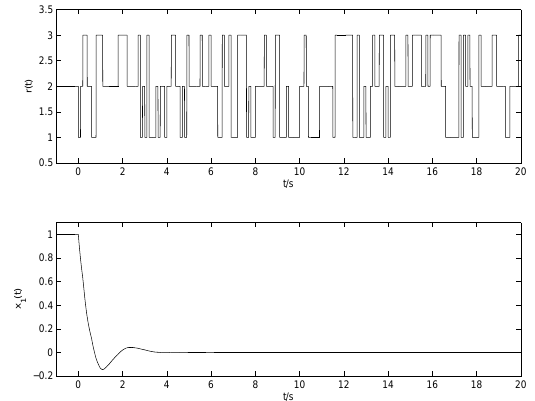
Figure 1: Time response of the state variable x 1 ( t ) of the MJNNS.